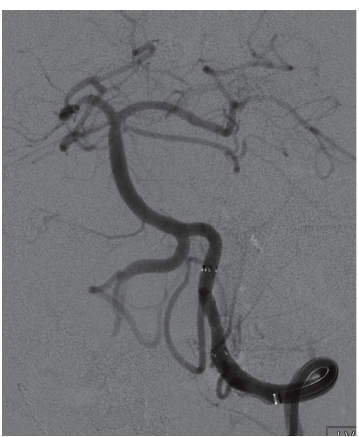
Figure 4: Left vertebral artery angiogram image demonstrating successful